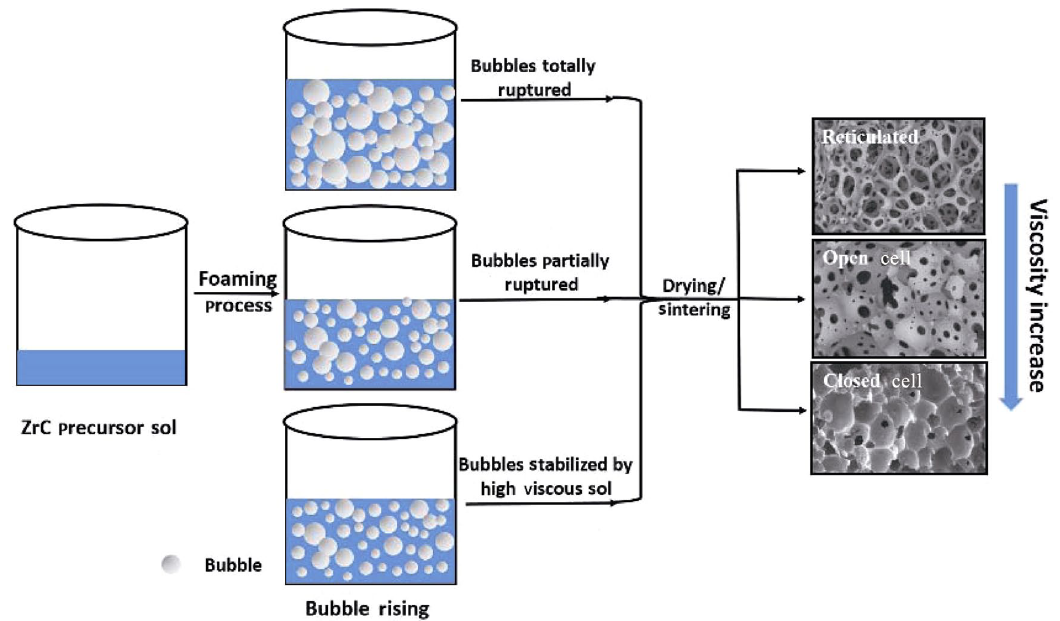
Fig. 8 Schematic illustration of the bubble growth and stabilization and the final microstructure of stoichiometric ZrC foams